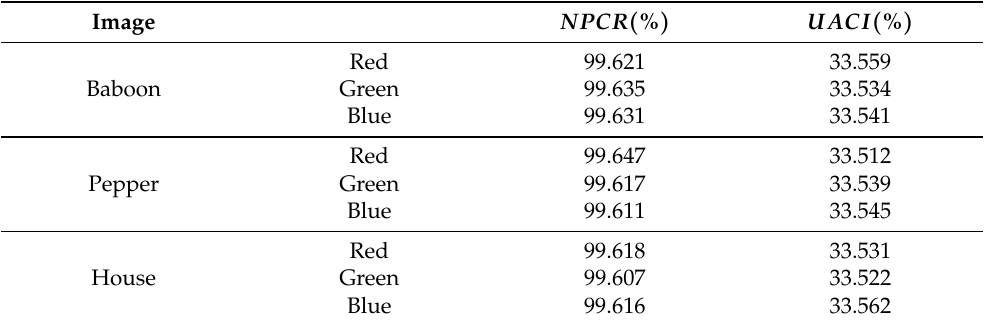
Table 5. NPCR and UACI measures for cipher images of the proposed encryption